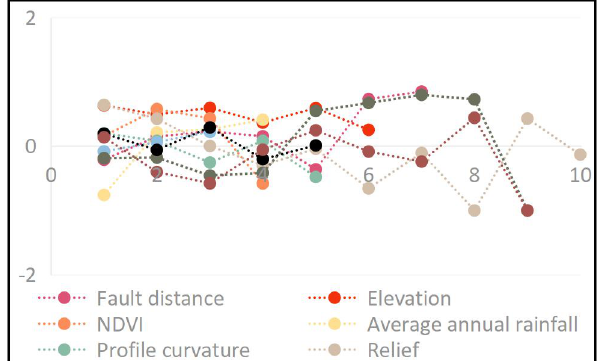
Figure 11. CF value floating-point diagram.